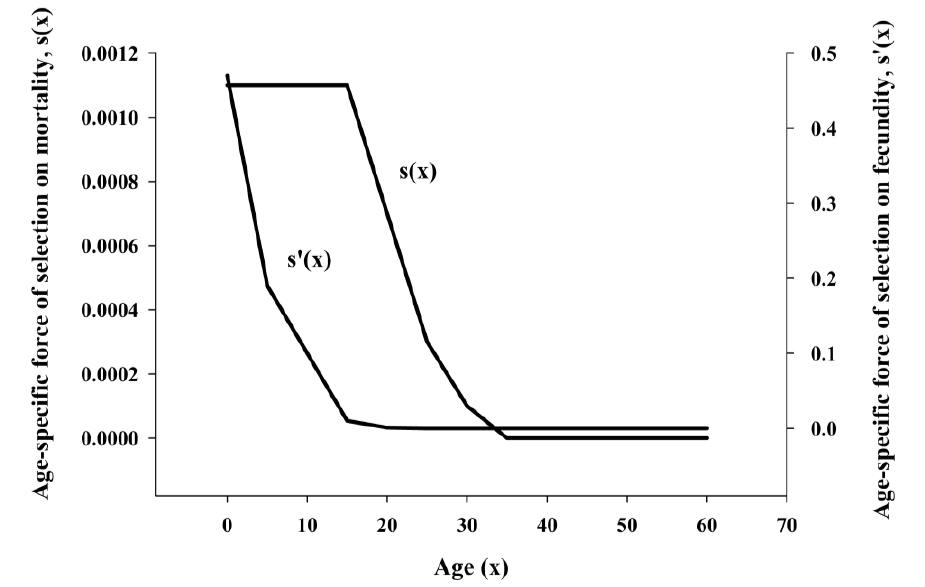
Figure 1. Hamilton’s calculation on the force of natural selection on mortality ( s ( x )) and fecundity ( s ’( x )). Data used are from life-tables of the United States between 2000 and 2004 (Adapted from [2]).